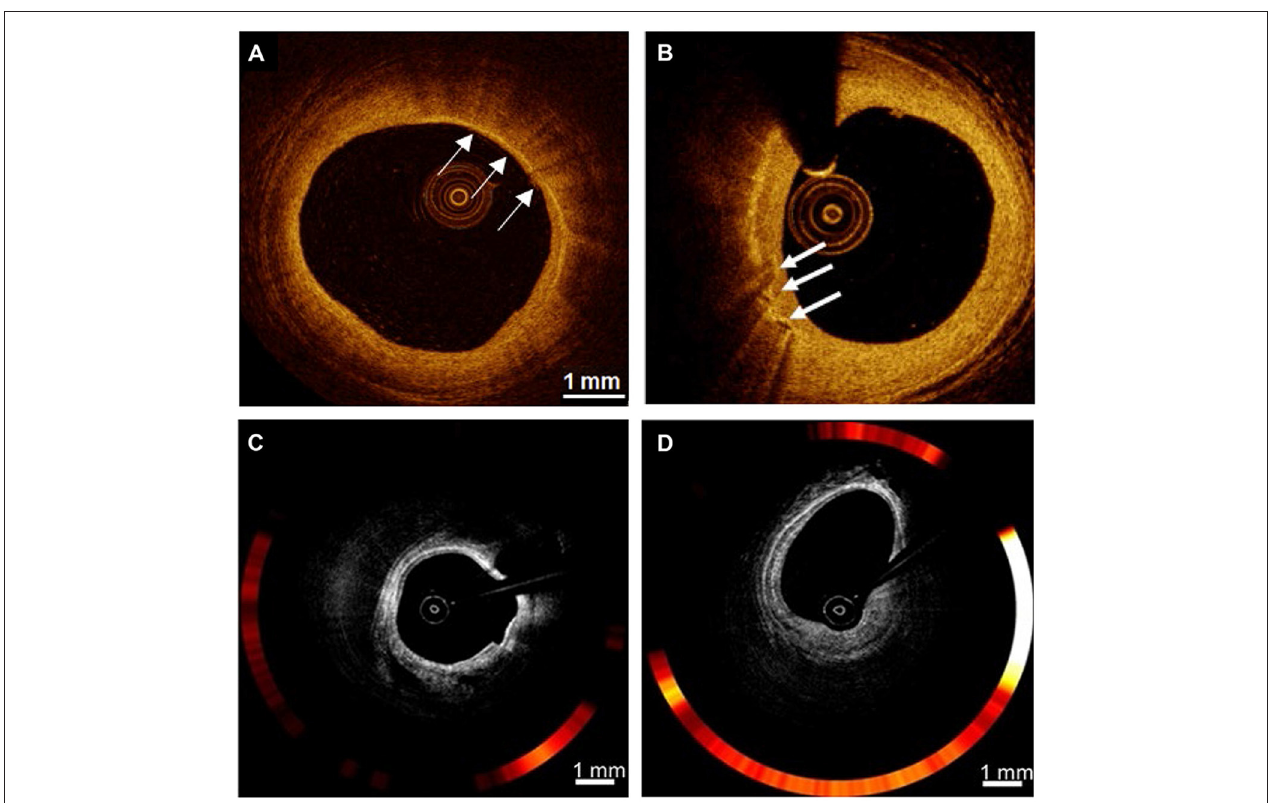
FIGURE 4 | Examples of nonmolecular imaging for macrophages in atherosclerosis. (A,B) OCT cross-section images of the atherosclerotic vessel lumen, the location indicated by the white arrow is the macrophage. ( C,D) Macrophages with robust NIRF signals on OCT-NIRF, and its content can be judged by red signal intensity; Focal plaque with surface infiltration of lipid-laden macrophages [adapted from